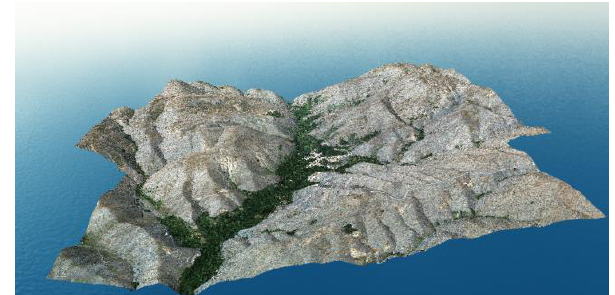
Figure 2. Dehbar